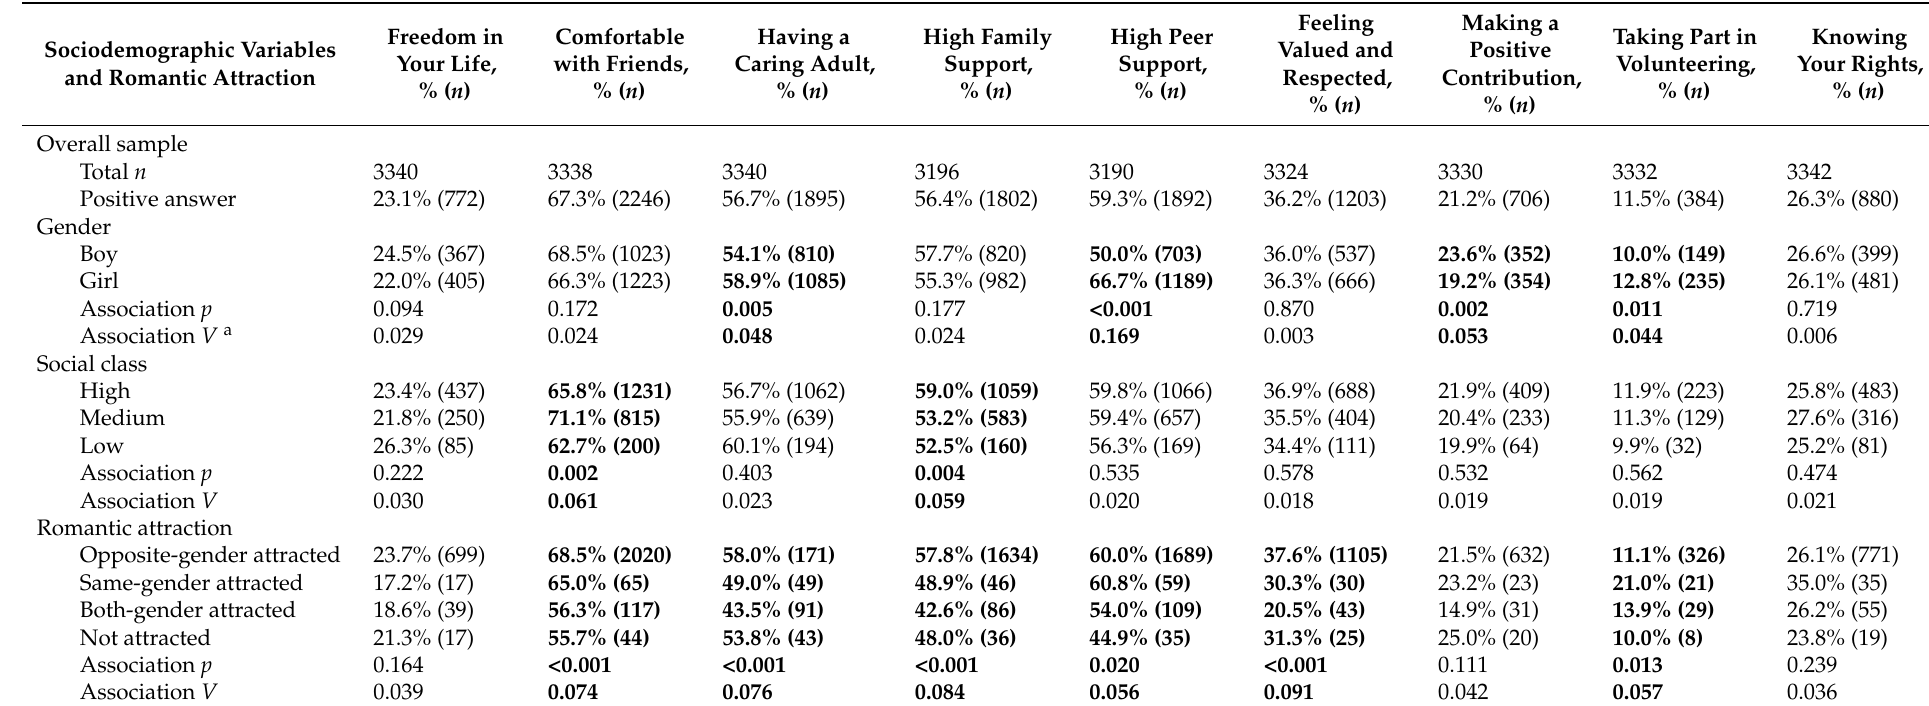
Table 3. Descriptive statistics for positive BOBF Outcome 5 indicators in the overall sample, by gender, social class, and romantic